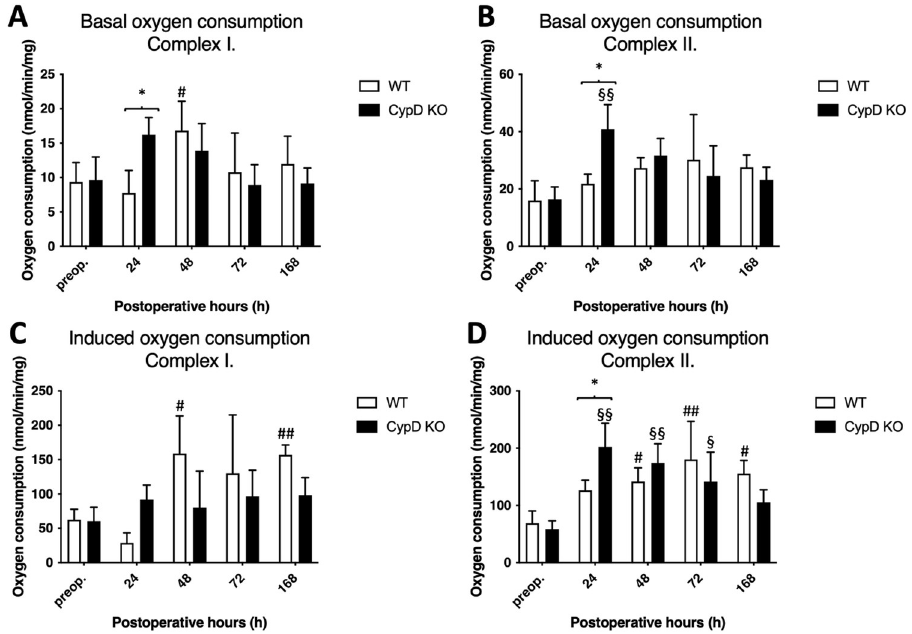
Fig 2. Changes in oxygen consumption levels. Basal (A and B) and substrate (complex I: Glutamate-malate complex II: Succinate) induced (C and D) oxygen consumption preoperatively (preop., 0 h), and at 24 h, 48 h, 72 h, and 168 h after Associating Liver Partition and Portal vein ligation for Staged hepatectomy (ALPPS) (N = 6 per time point per group). � P < 0.050, �� P < 0.0010 versus WT; # P < 0.050, ## P < 0.001 wild type (WT) versus corresponding controls (preop.); § P < 0.050, §§ P < 0.0010 CypD KO versus corresponding controls (preop.). Statistical analysis was performed with a two-way ANOVA and Tukey’s post hoc test.